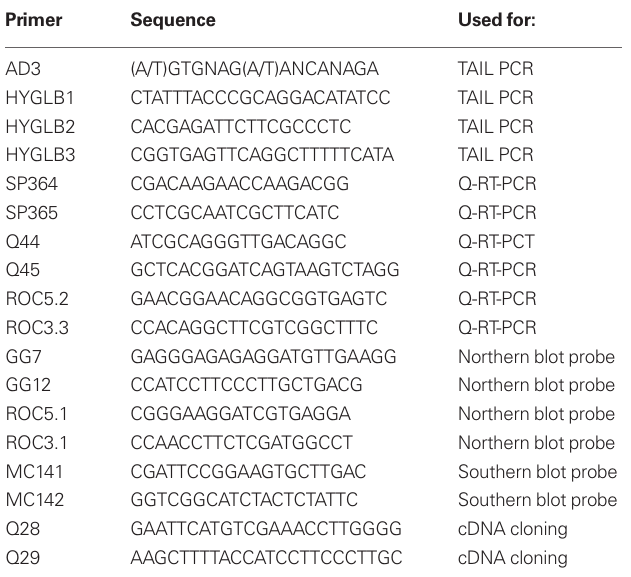
Table 1 | Sequences of PCR